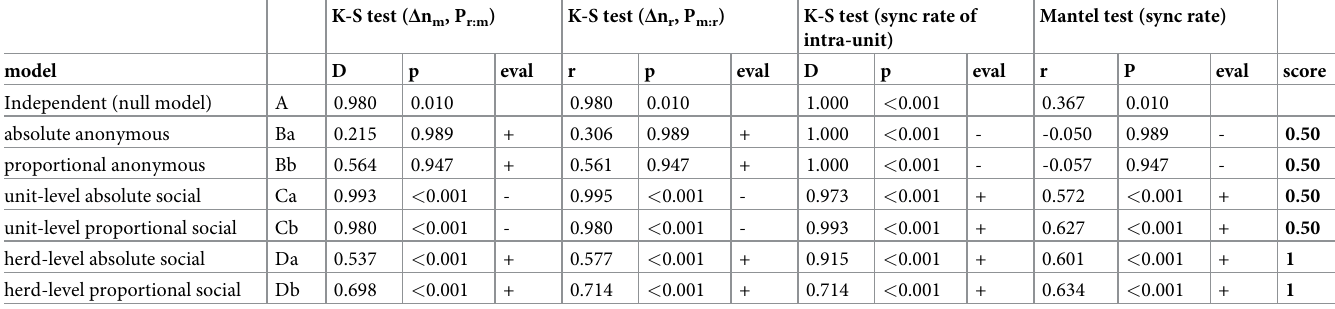
“Eval” (evaluation) is “+” when the result is better than the independent model and “-” when not. The model with smaller D and larger r is considered as better. Score is the percentage of the tests which showed better results than the independent (null)